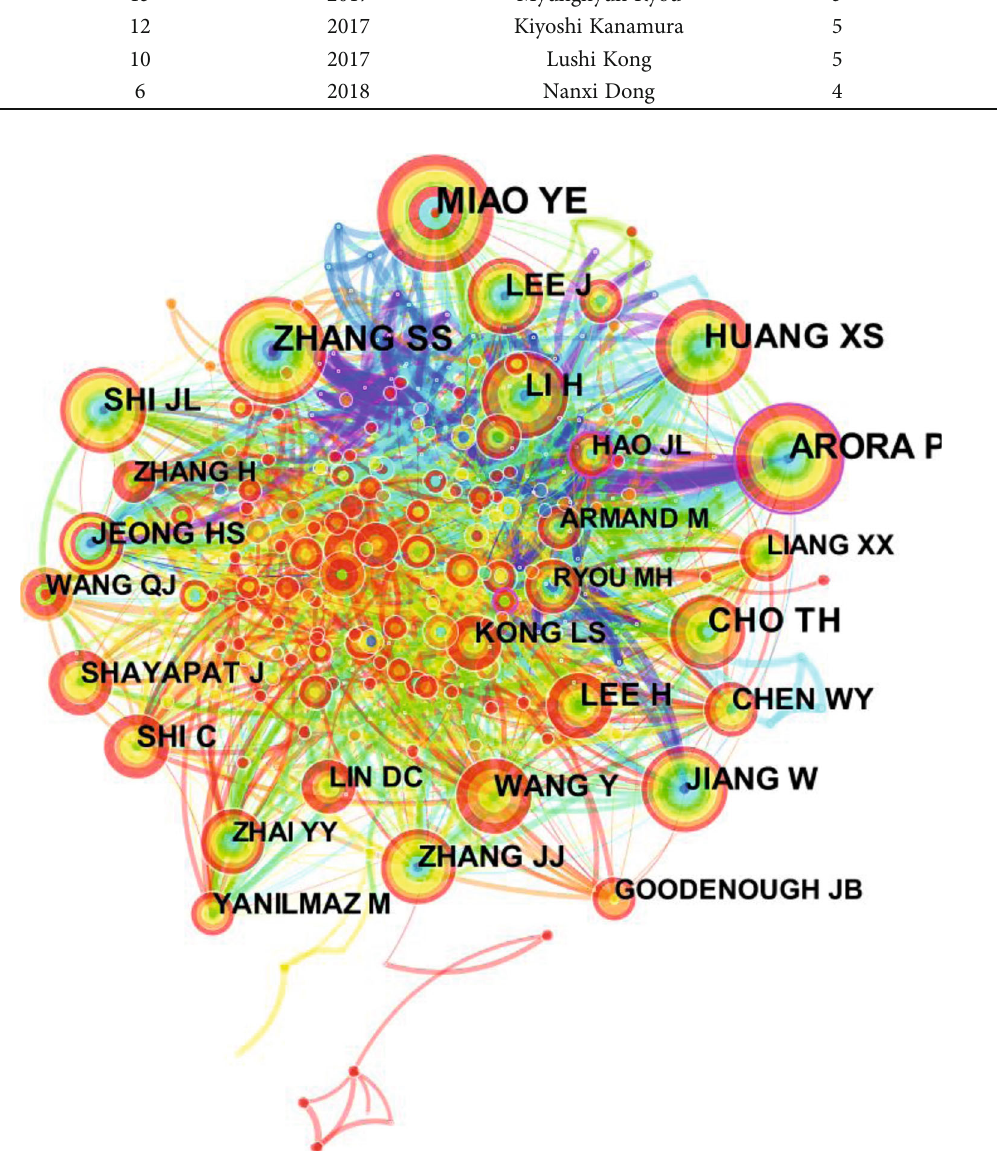
Figure 6: Author cocitation network